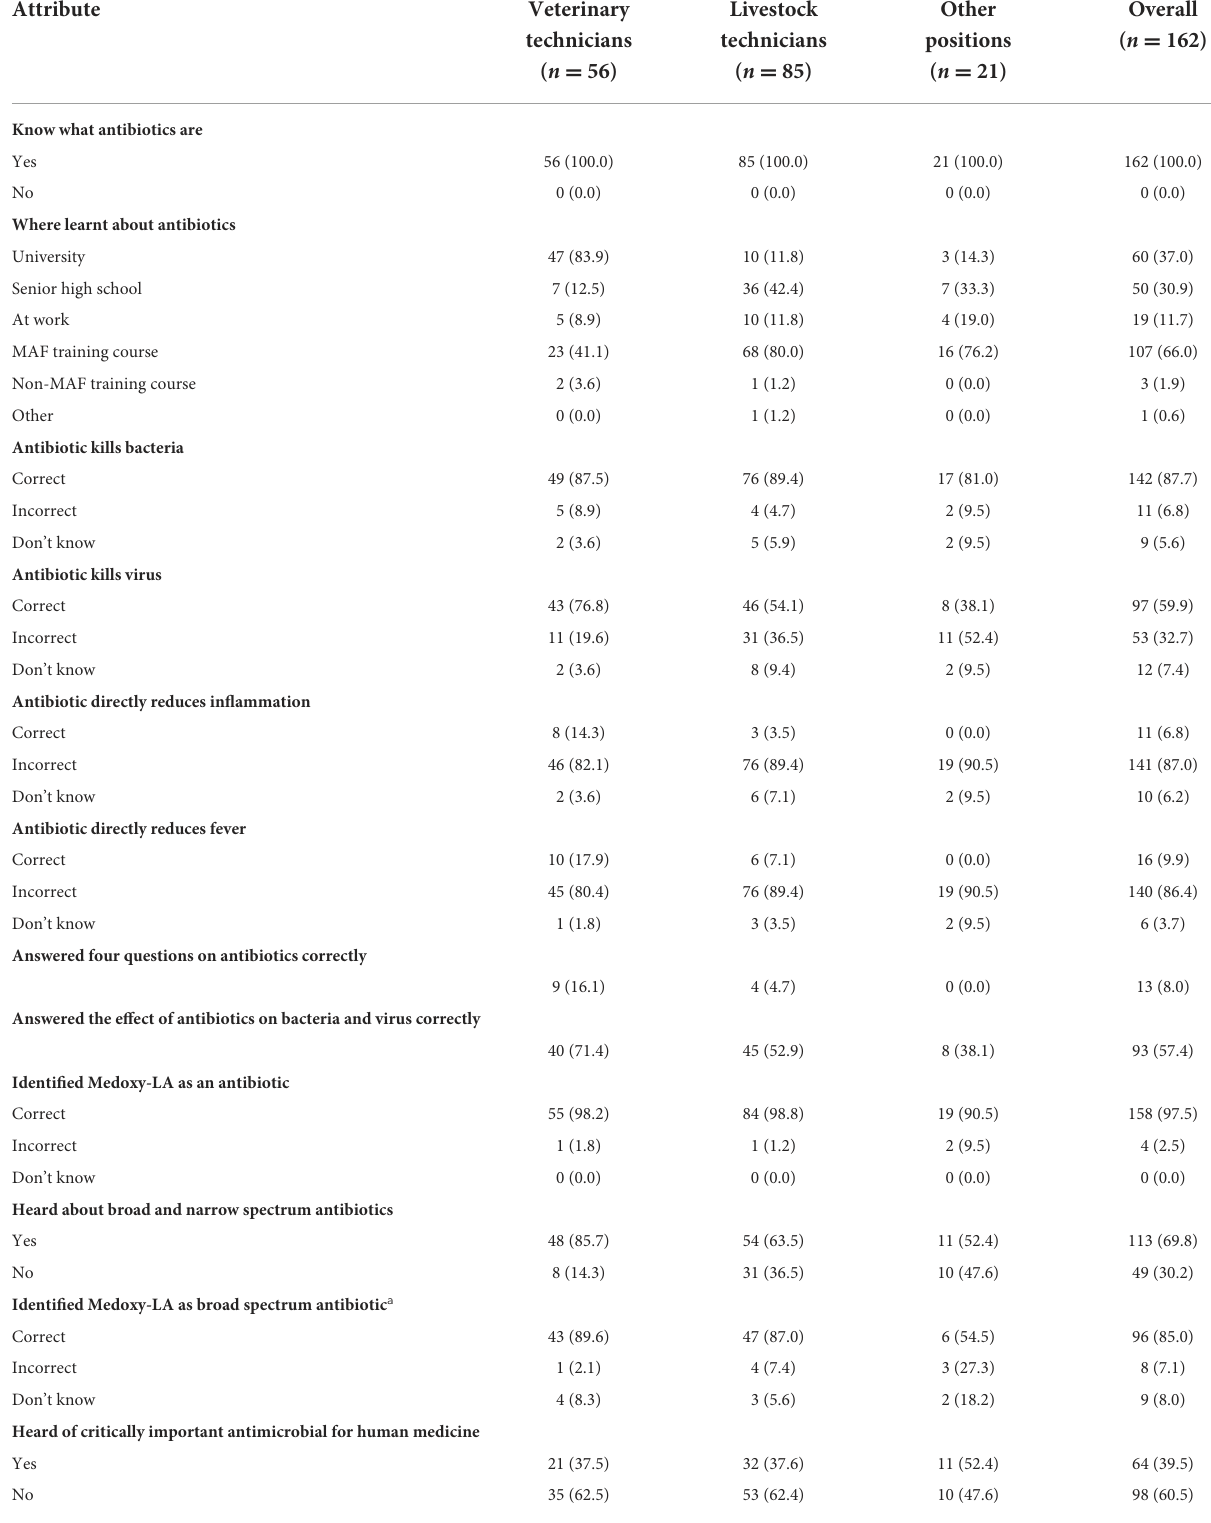
TABLE 2 Knowledge of antibiotics (overall and by position) of government animal health workers.